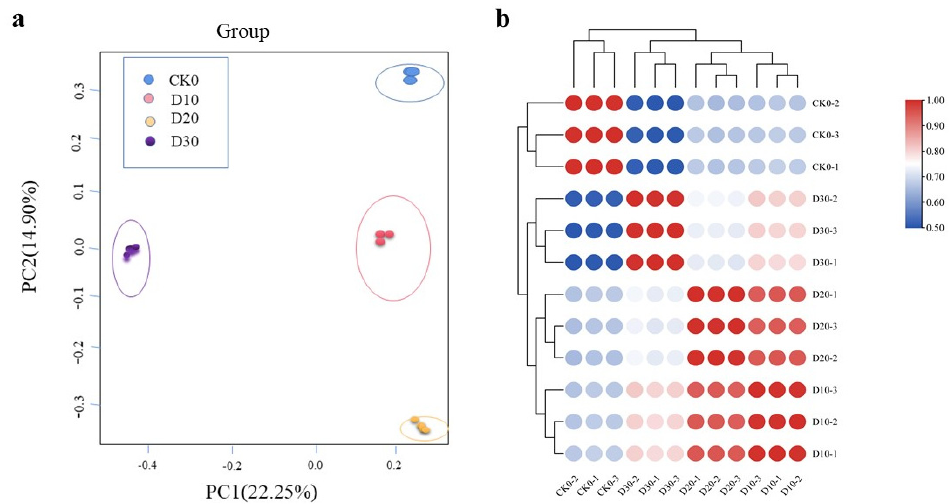
Figure 1. Correlations between the four samples. ( a ) PCA map for all four time points. ( b ) PCC map for all four time points.